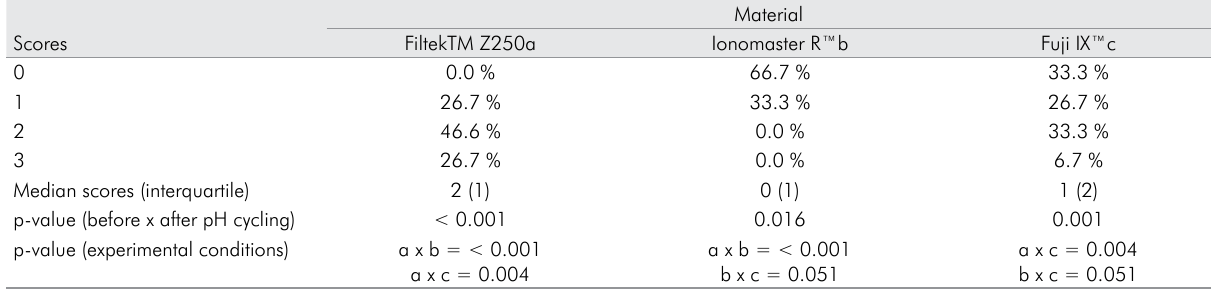
Table 2. pH cycling score values of white spot lesions for experimental groups with median scores and interquartiles of restor- ative